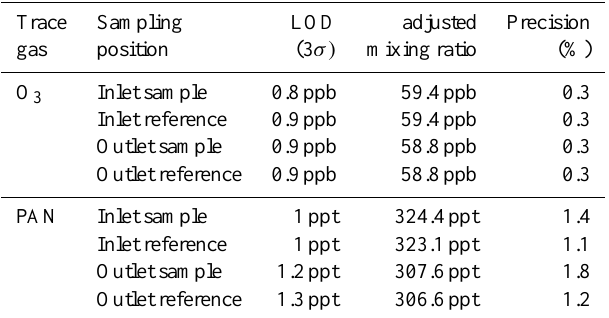
Table 3. Detection limit (LOD) and precision of the twin-cuvette system at different sampling positions. The determination of the LOD is based on 3 σ of the blank value.